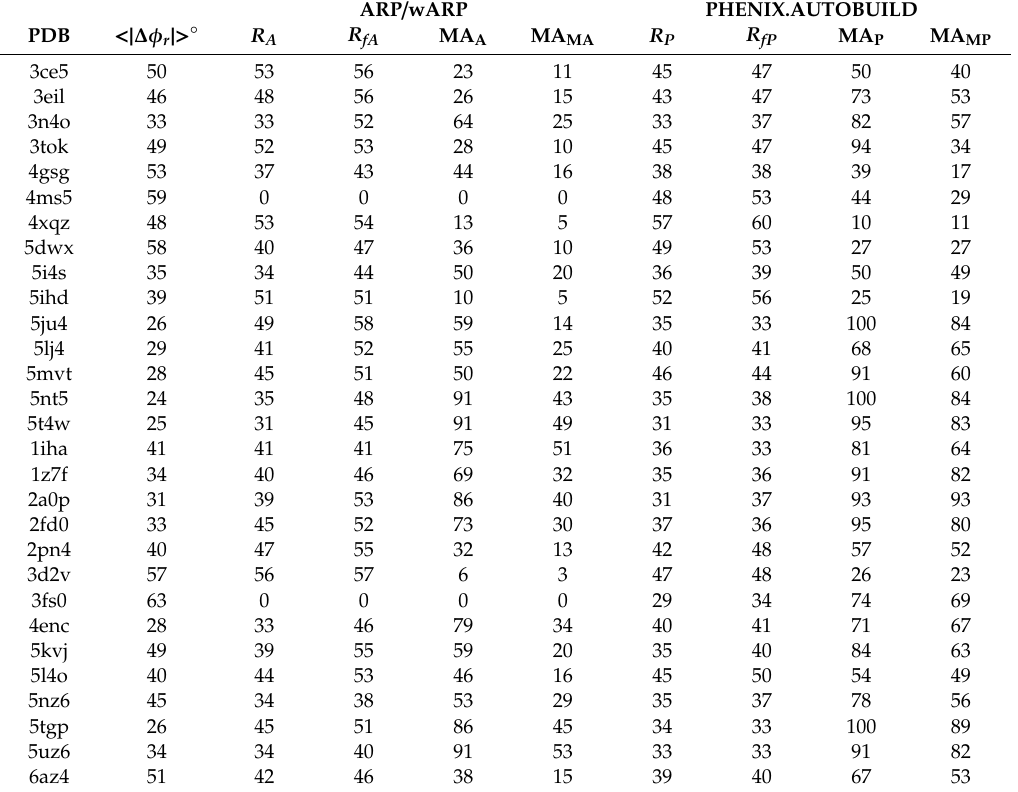
Table 4. ARP / wARP and PHENIX.AUTOBUILD experimental results for the 29 test structures. PDB (cid:12) (cid:12) ◦ is the average phase error available at the end of the SYNERGY refinement (cid:12) (cid:12) is their PDB code; (cid:12) ∆ φ r (cid:12) process. The corresponding φ r phases are the input for ARP / wARP and PHENIX.AUTOBUILD. R A , R fA , MA A and MA MA are the R , R f , MA and MA M values obtained at the end of the automatic runs of ARP / wARP; R P , R fP , MA P and MA MP are the corresponding values obtained at the end of the automatic runs of PHENIX.AUTOBUILD. R and MA values are